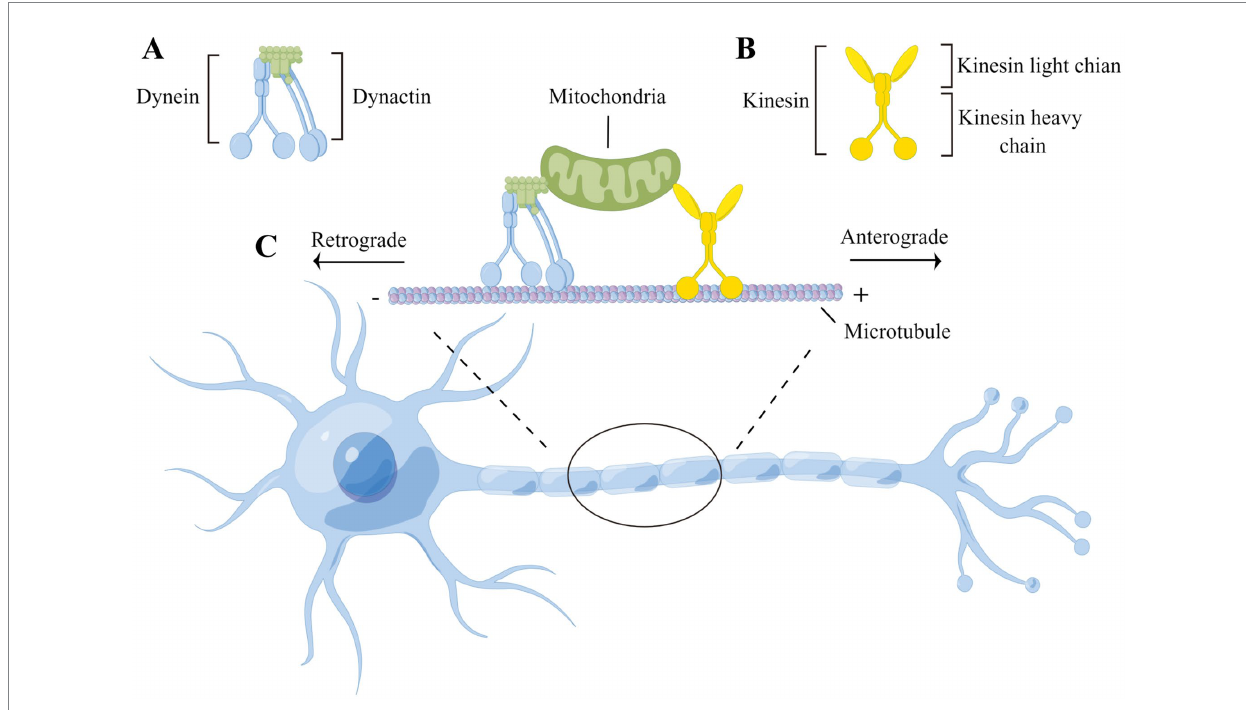
FIGURE 1 Microtubule-based neuronal axonal transport. (A) Dynein transport complex consists of dynein’s heavy, medium, medium-light, and light chains and dynactin, which move along the axon to transport cargoes in a retrograde direction (i.e., toward the minus end of the microtubule and cell body); (B) Kinesin consists of two heavy chains and two light chains, which transport cargoes in a anterograde direction along the axon (i.e., toward the plus end of the microtubule and synaptic terminals); (C) The heavy chains of both kinesin and dynein have a motor structural domain that binds to the microtubule, hydrolyzes ATP, and propels cargo along the microtubule track. The cargoes are attached to motor proteins via kinesin’s light chain or